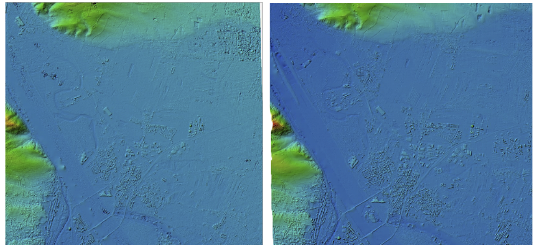
Figure 7. Multi-temporal (1958 - left and 1976 - right) DSM (5 m resolution) over Vienna (Austria).